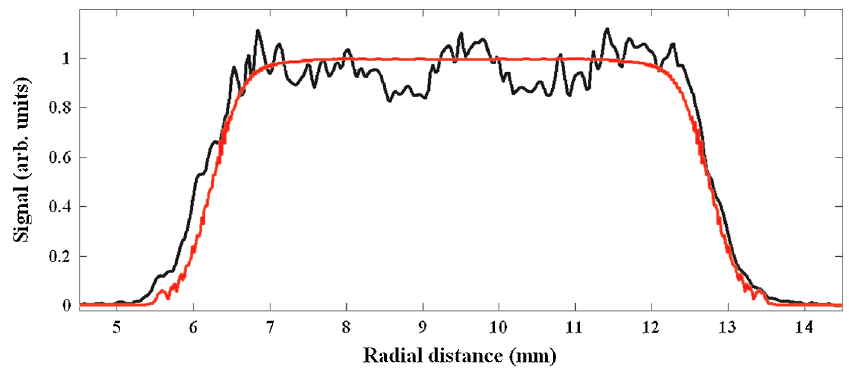
FIG. 5. (Color) Horizontal line scan of the output spatial beam profile of Fig. 4 at 10 cm from the (cid:5) shaper: (black line) experimental profile, (blue line) corresponding ZEMAX simulation.